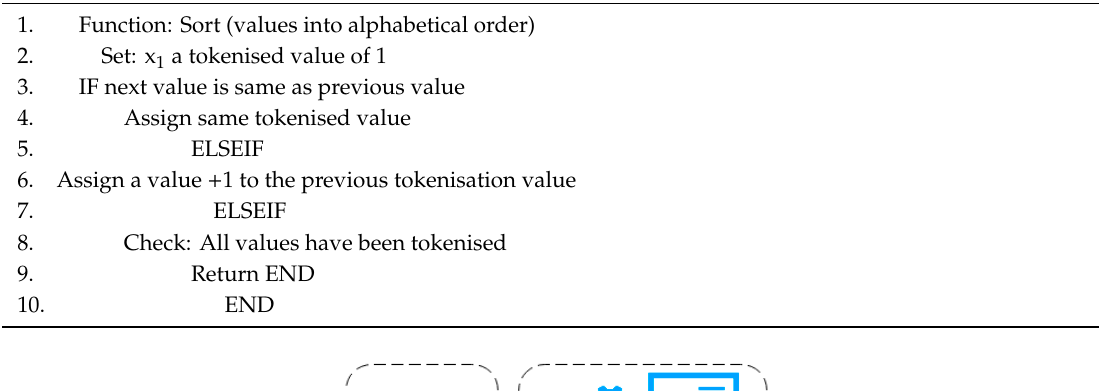
Algorithm 1. Tokenisation algorithm